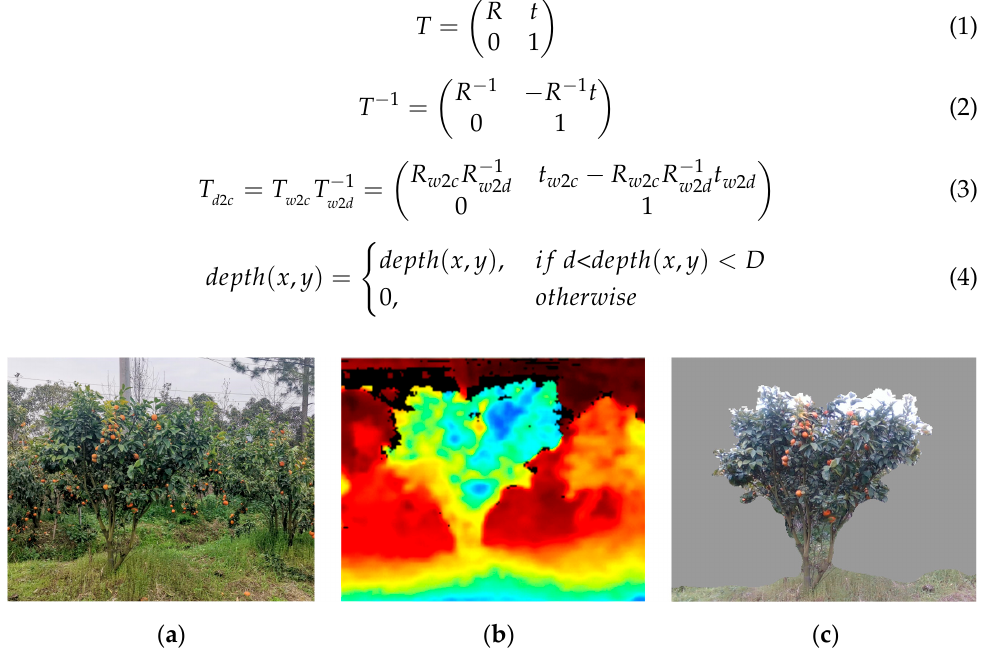
Figure 3. Tree crown RGB-D image generation process: ( a ) RGB image; ( b ) depth image; ( c ) RGB-D image.